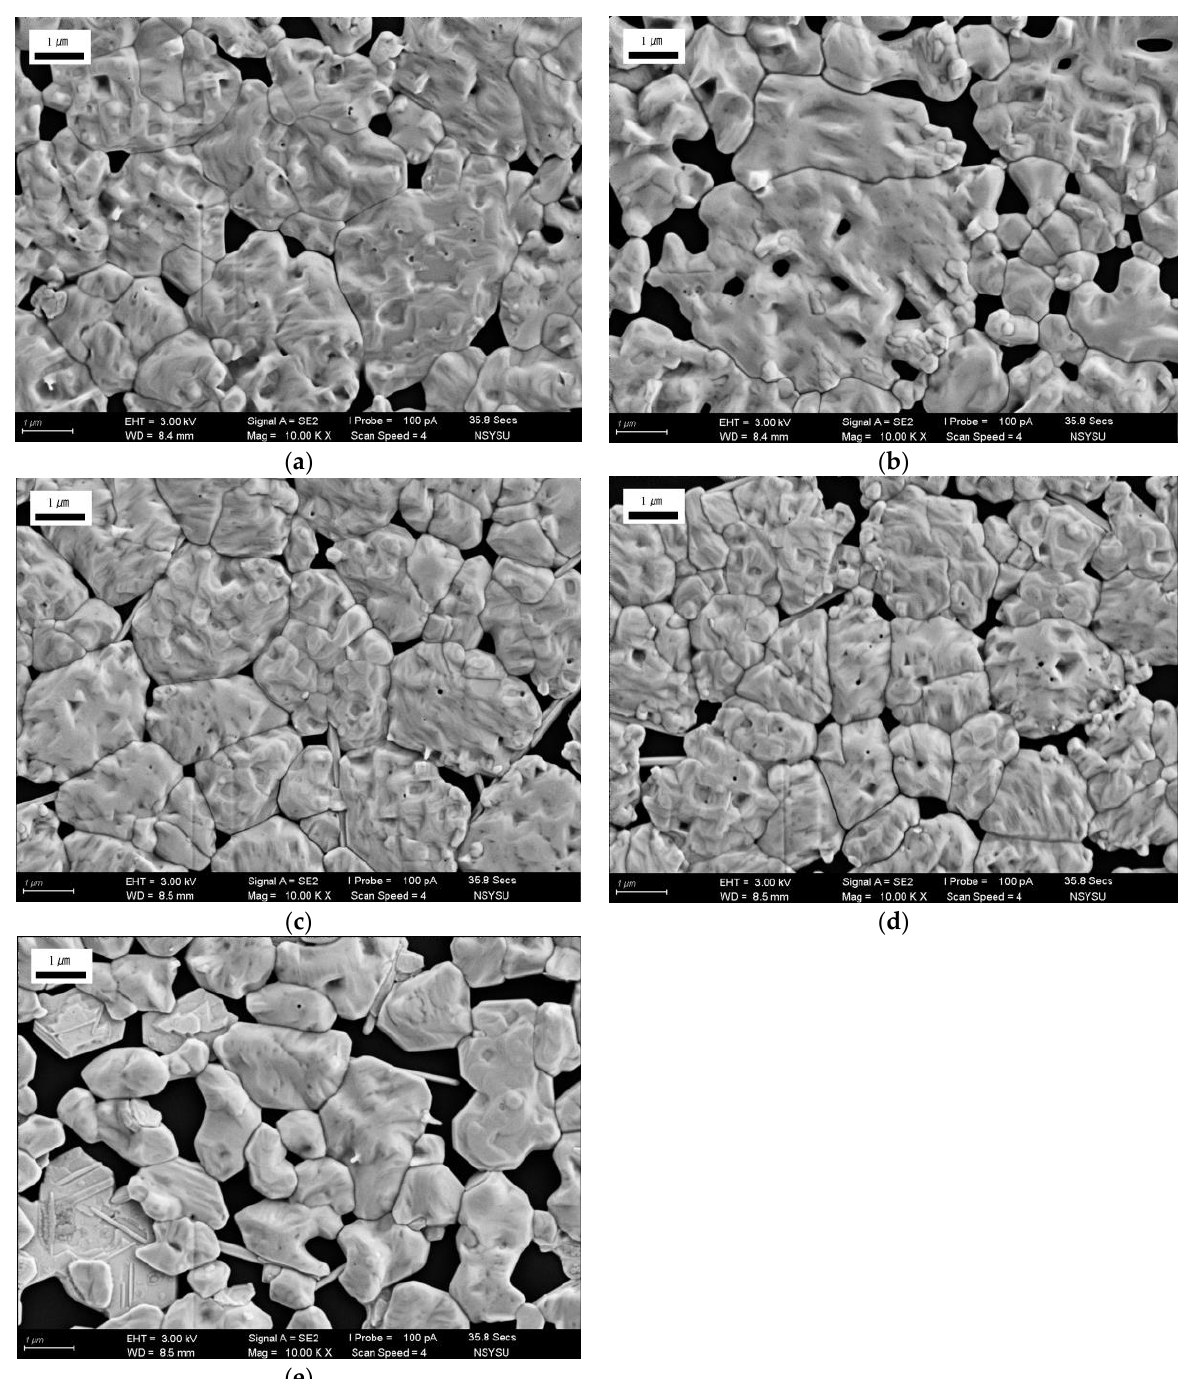
Figure 3. SEM images (top view) of ( a ) pristine PQD film and annealed PQD thin films at different temperatures with scale size of 1 µ m: ( b ) 100 ◦ C, ( c ) 120 ◦ C, ( d ) 140 ◦ C, ( e ) 160 ◦